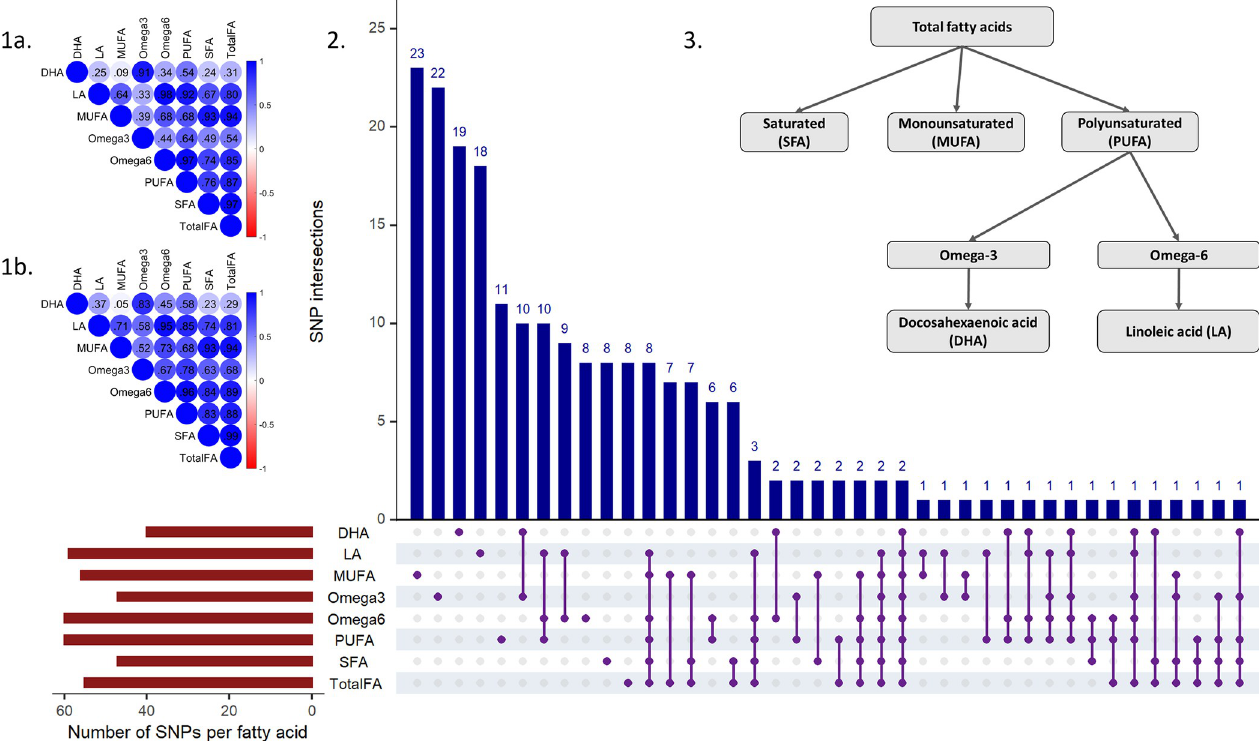
Fig 2. (1a) Pearson correlation coefficient heatmap between phenotypic circulating fatty acid measurements. (1b) Genetic correlation heatmap between the fatty acid measurements. (2) Additional information on the genetic instruments used in the analysis. Independent biallelic genetic variants that are associated with fatty acids below P = 5 × 10 − 8 , have MAF > 0.1 and HWE P > 10 − 6 were used as instruments. Independence was assessed through clumping with r 2 < 0.001 and 10 million bases clumping window. Dark red horizontal bars at the left bottom corner show the total number of genetic variants used as instruments per fatty acid. Dark blue vertical bars depict the number of genetic variants within each intersection. SNP intersections are defined with the purple dots below the vertical bars, indicating SNP overlap between groups, e.g., the first bar refers to MUFA having 23 unique SNPs, the sixth bar refers to 10 common SNPs between DHA and omega-3 etc. ( 3) Hierarchical order of the fatty acids. DHA, docosahexaenoic acid; HWE, Hardy–Weinberg equilibrium; LA, linoleic acid; MAF, minor allele frequency; MUFA, monounsaturated fatty acid; PUFA, polyunsaturated fatty acid; SFA, saturated fatty acid; SNP, single nucleotide polymorphism; total FA, total fatty